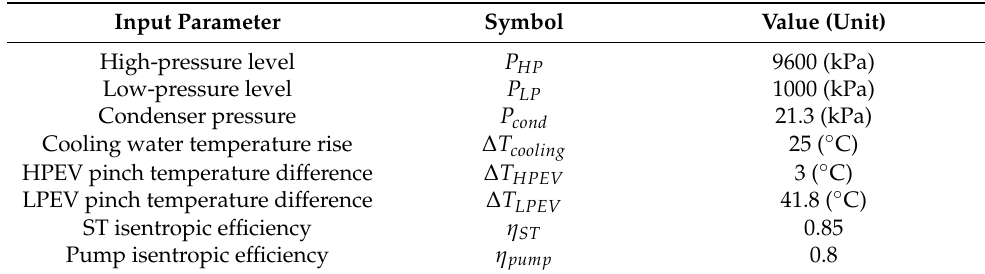
Table 2. Technical input data of the steam turbine